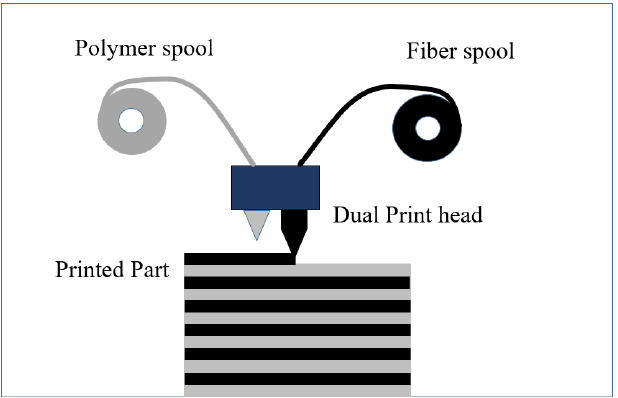
Figure 2. Schematic representation of dual head MF 3D printer.